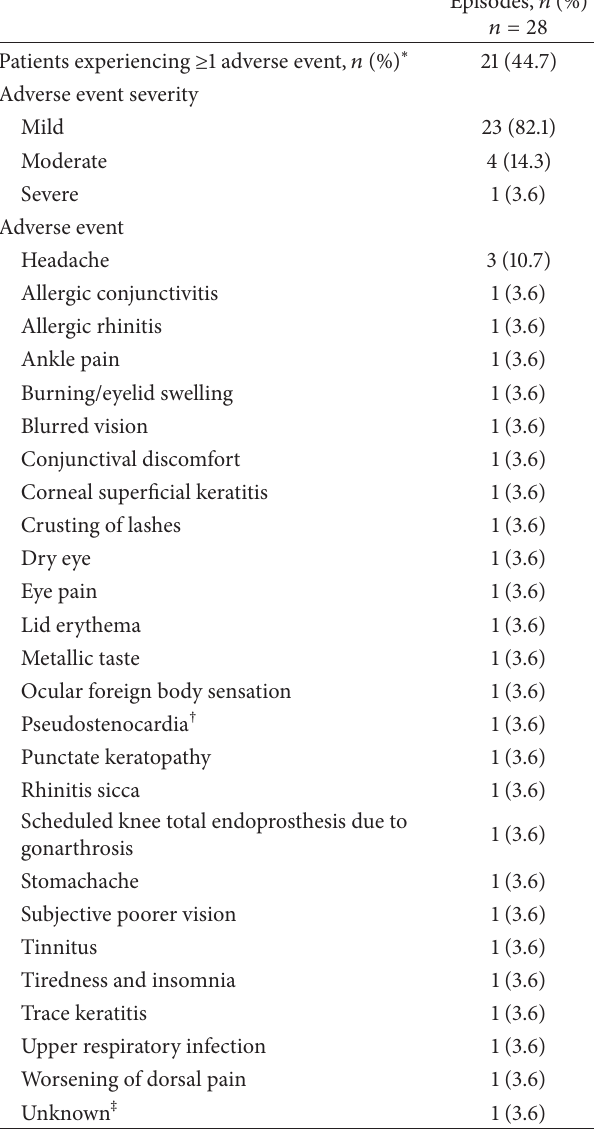
Table 2: Adverse events (safety